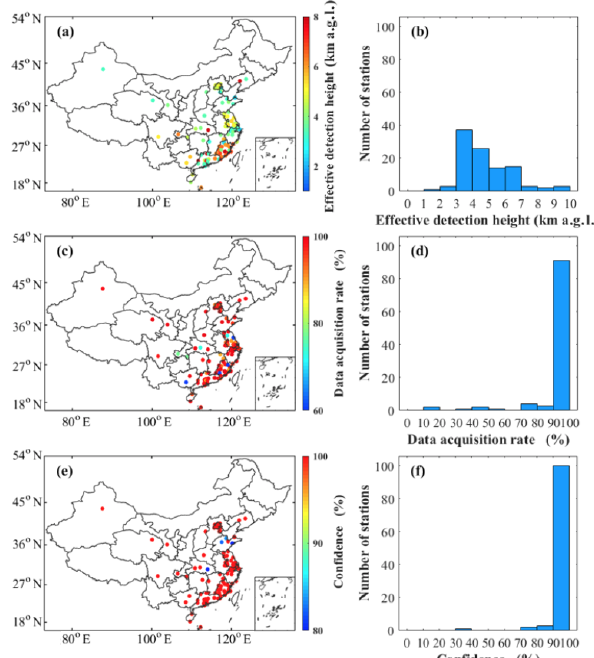
Figure 3. Spatial distribution of average wind field at different heights: (a) 500m, (b) 1000m, (c) 1500m and (d) 2500m above ground level (a.g.l.). Also shown is (e) the three-dimensional atmo- spheric wind field observed by the radar wind profiler network of China.